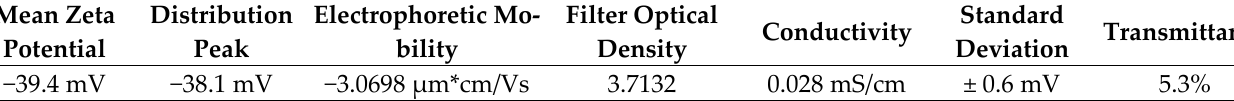
Figure 4. The distribution of the zeta capacity on the CF-GNPs nanofluid at 25 °C.